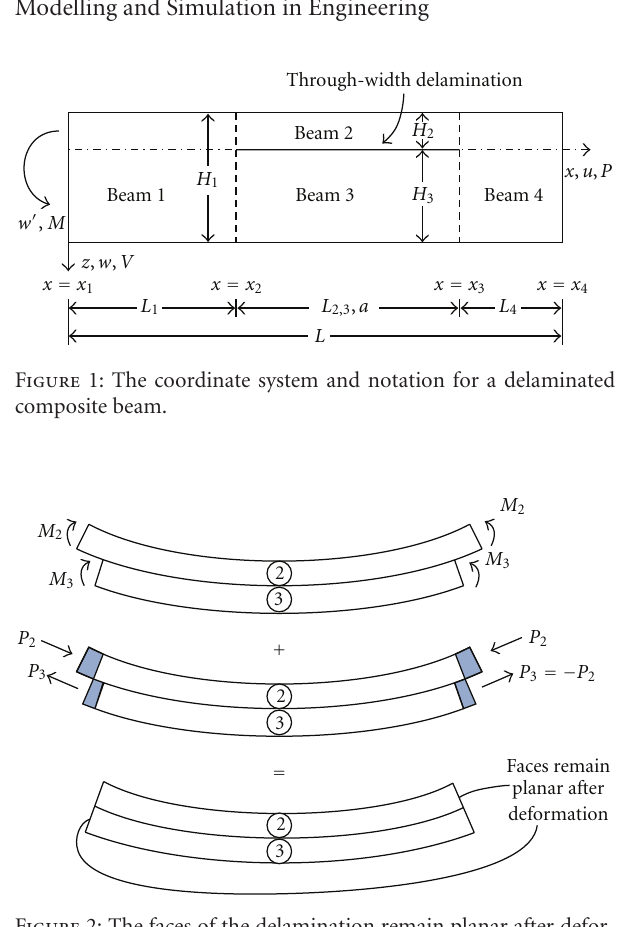
Figure 2: The faces of the delamination remain planar after defor-